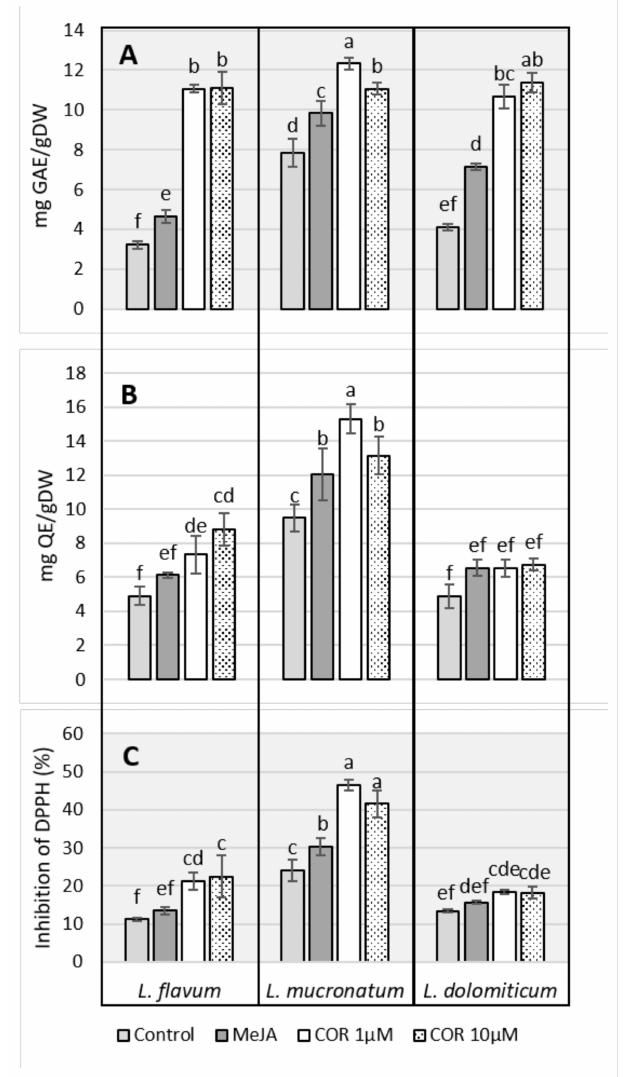
Figure 3. Effect of elicitors on L. flavum , L. mucronatum and L. dolomiticum ARc; control (light gray), MeJA (100 µ M, dark gray), COR 1 µ M (white), COR 10 µ M (dotted). ( A ) Phenol content expressed as gallic acid equivalent, mg GAE/g DW. ( B ) Flavonoid content expressed as quercetin equivalent, mg QE/g DW. ( C ) Antioxidant capacity expressed as percent of inhibition of DPPH. Each value is the mean of three biological replicates ± SD. The samples with different letters are significantly different at p ≤ 0.05 according to Duncan